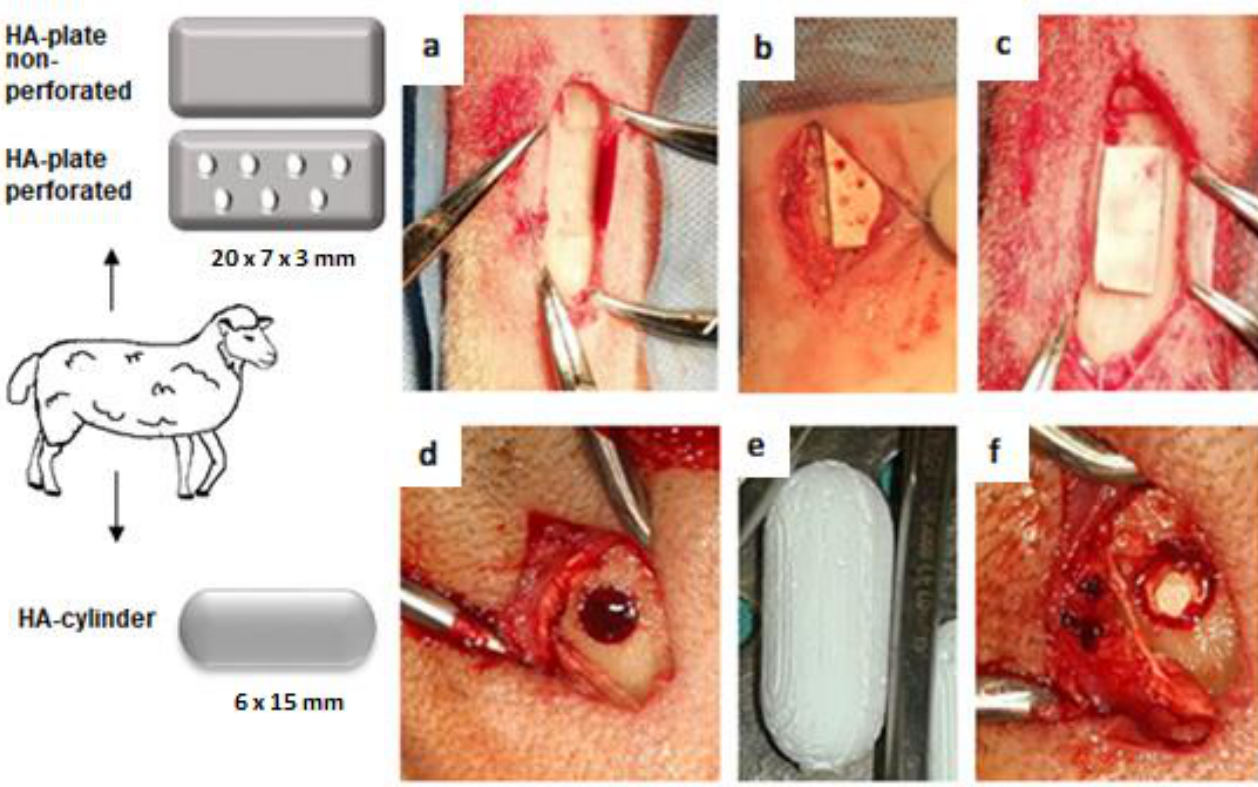
Figure 1. Surgical procedure. ( a , d ) Bone defect in metatarsal bone. ( b ) Perforated HA plate inserted to the bone defect. ( c ) Nonperforated HA plate inserted to the bone defect. ( e ) HA cylinder. ( f ) HA cylinder inserted to the bone